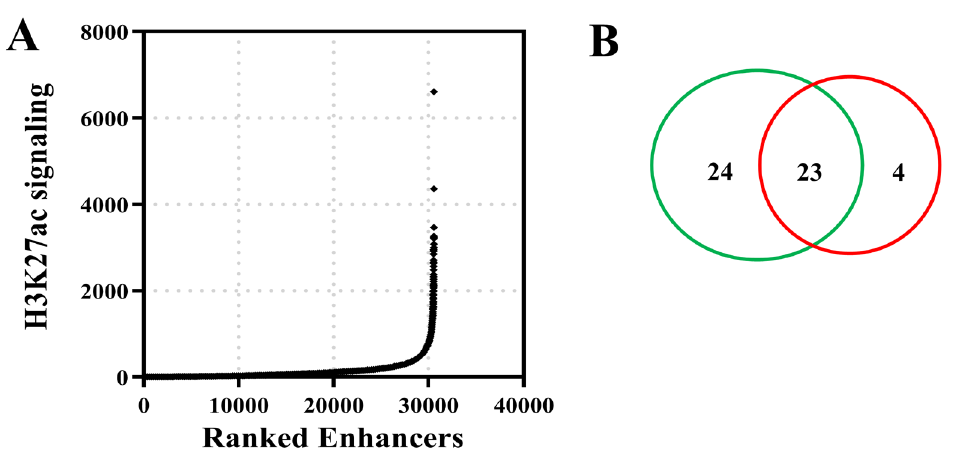
Figure 4. Identification of super-enhancer-controlled genes related to glucose metabolism in PDTC. (A) Super-enhancers were screened in CAL-62 cells using GSE120177 dataset. (B) Venn diagram to show the intersection between super-enhancers-adjacent genes located in TCA cycle or pyruvate metabolism (green circle) and upregulated genes in PDTC located in TCA cycle or pyruvate metabolism (red